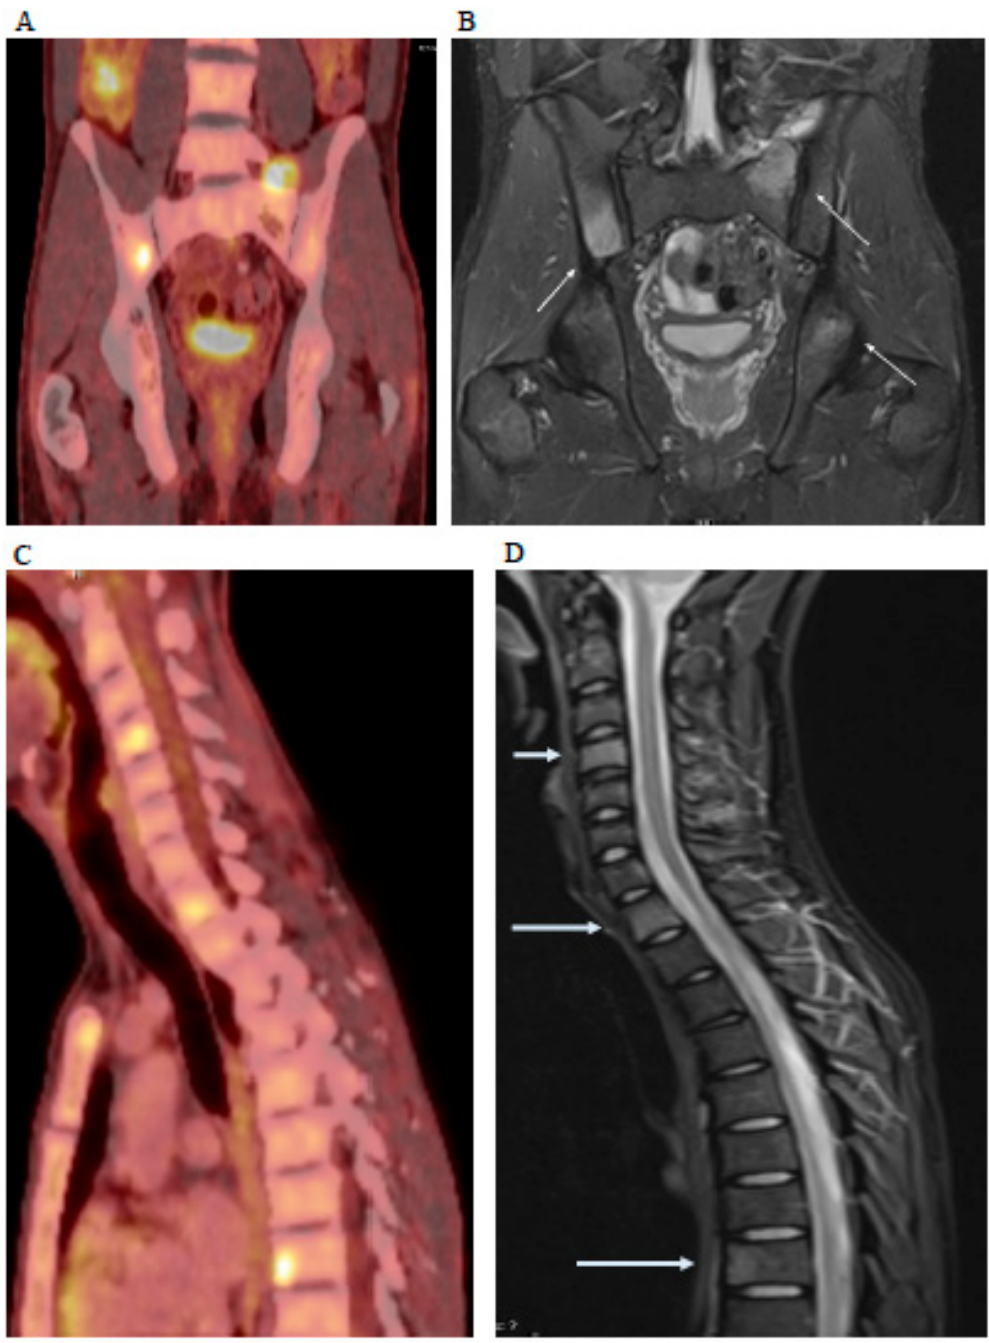
Figure 1 . A 24-year old male bricklayer was admitted to a local hospital with a 4-week long history of fever, diarrhea, weight loss, night sweats, and general malaise. The patient had a two-year history of stable Crohn’s disease treated with weekly injections of a TNF-alpha inhibitor. One month prior to admission he had received an additional course of Azathioprine, which was terminated due to side effects. The patient had two domestic cats and a dog. Upon admission, the patient was febrile (39.5 ◦ C) with a blood pressure of 112/60 mmHg. Laboratory test showed leucocytes of 3.0 × 10 9 /L and C-reactive protein of 87 mg/L. The chest X-ray was normal and urine dip stick and urine culture were negative. All blood cultures were negative. He was treated empirically with Piperacillin/Tazobactam and Metronidazole. Consequently, echocardiography (Echo) showed no abnormal findings. Computed tomography (CT) of the thorax and abdomen showed pericardial fluid and moderate ascites compatible with Crohn’s disease. In addition, a solitary infarct-like lesion was seen in the spleen and the liver was enlarged with several poorly defined hypodense lesions up to 1.5 cm. Next,